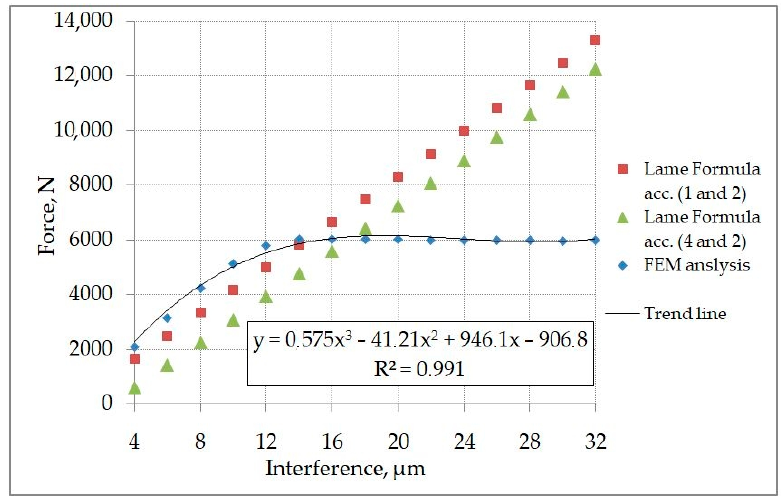
Figure 11. A graph of joint breaking forces, determined by means of formulas and numerical sim- ulation. simulation.